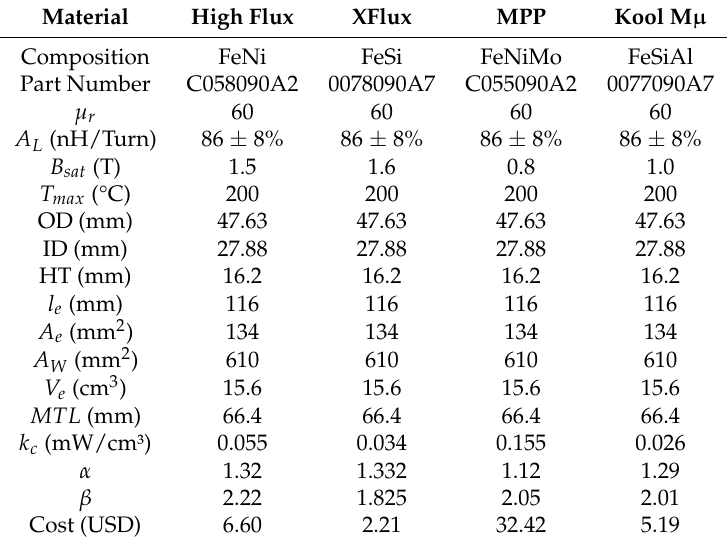
Table 5. Characteristics of the magnetic cores